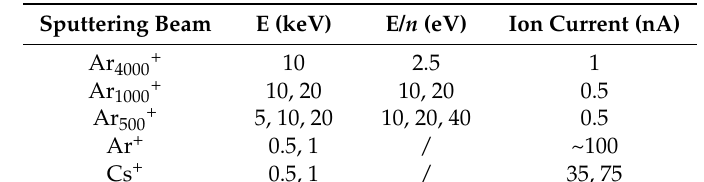
Table 1. Ion beam sputtering conditions: Cluster size, energy, energy-per-atom, and typical current values in ToF-SIMS depth profiles.